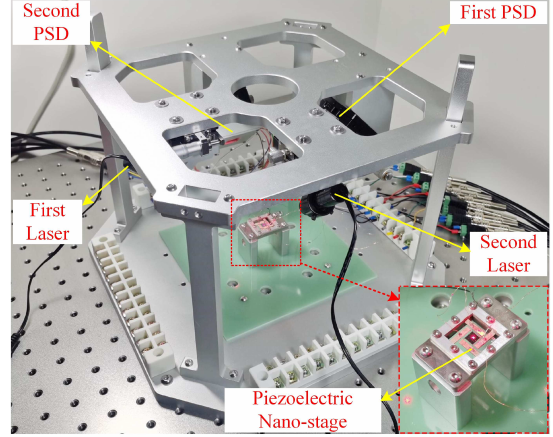
Figure 9. Apparatus of